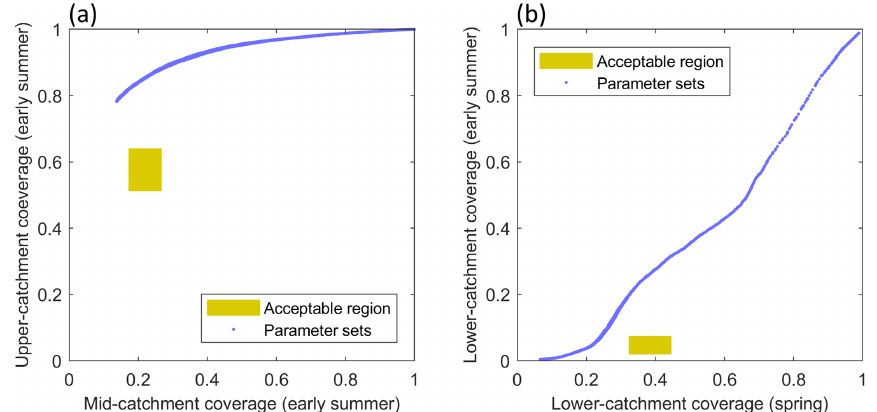
Figure 11. Simulated snow coverage signatures from the 5000 calibration runs (blue dots) for the TIM 1 -ROR 1 GHM configuration includ- ing early-summer mid-catchment and upper-catchment snow coverage signatures (a) , and lower-catchment spring and early-summer snow coverage signatures (b)